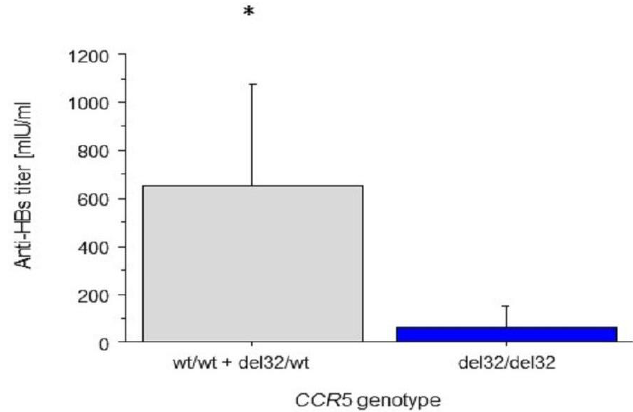
Figure 2. Anti-HBs titres by CCR 5 recessive genotype and age as a cofactor ( * p = 0.04; bars indicate standard deviations); n = 149.